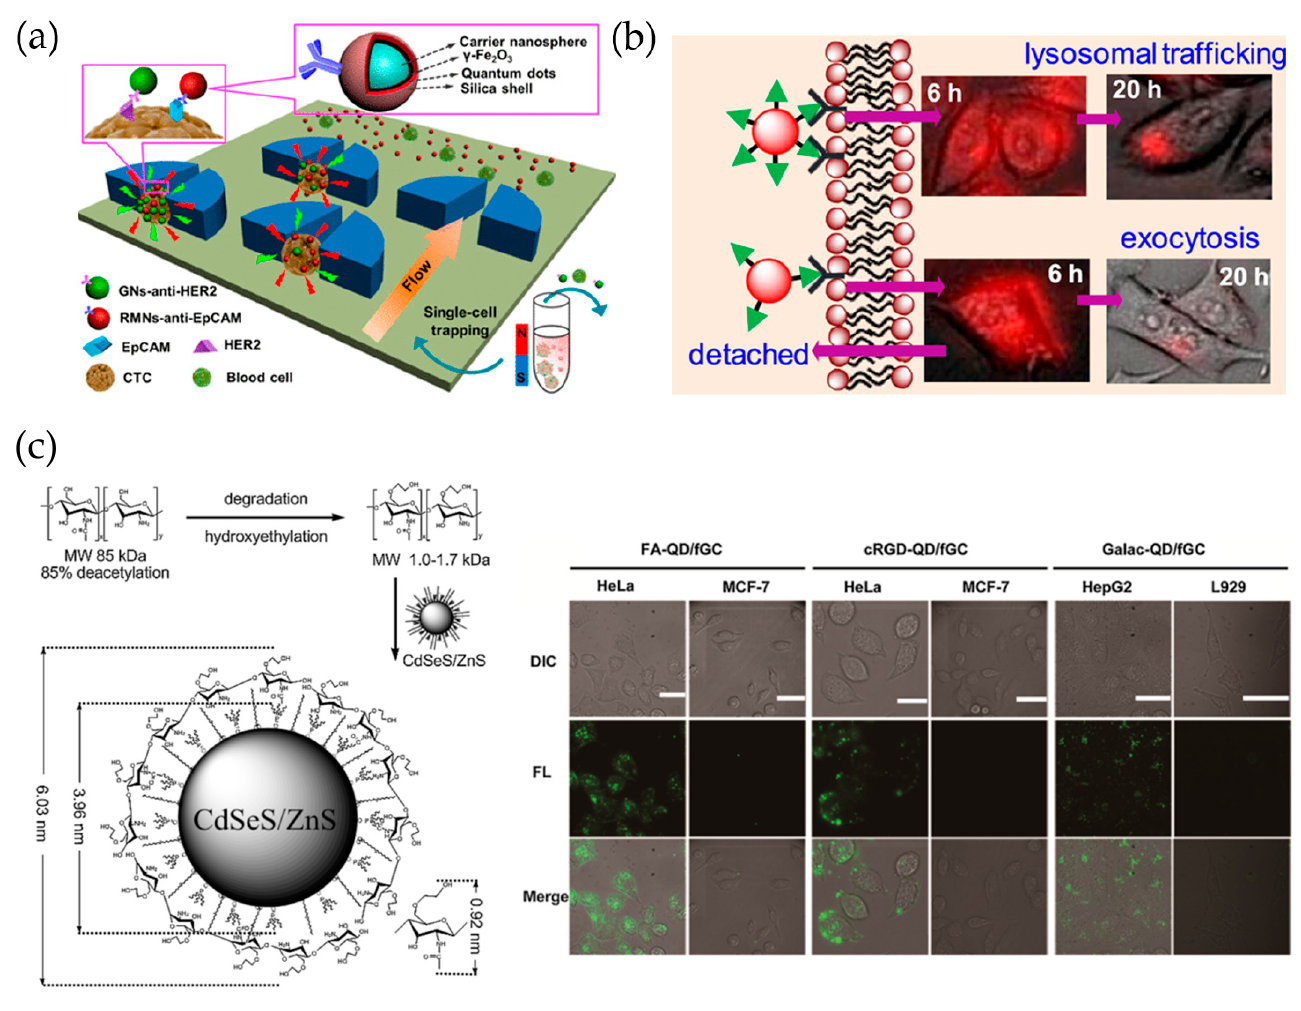
Figure 5. ( a ) Fabrication of IgG-QD@SiO 2 conjugate via surface modification of QD@SiO 2 and indirect immunoassay with IgG-QD@SiO 2 conjugate [68]. Reprinted with permission from Anal. Chem. 2018, 90, 17, 10518–10526. Copyright 2018 American Chemical Society. ( b ) Cell uptake of QDs with different bioconjugation multivalencies [73]. Reprinted with permission from Langmuir 2019, 35, 35, 11380–11388. Copyright 2019 American Chemical Society. ( c ) Synthesis and use (live-cell imaging) of glycol chitosan-shelled QDs (QD/fGC) [74].